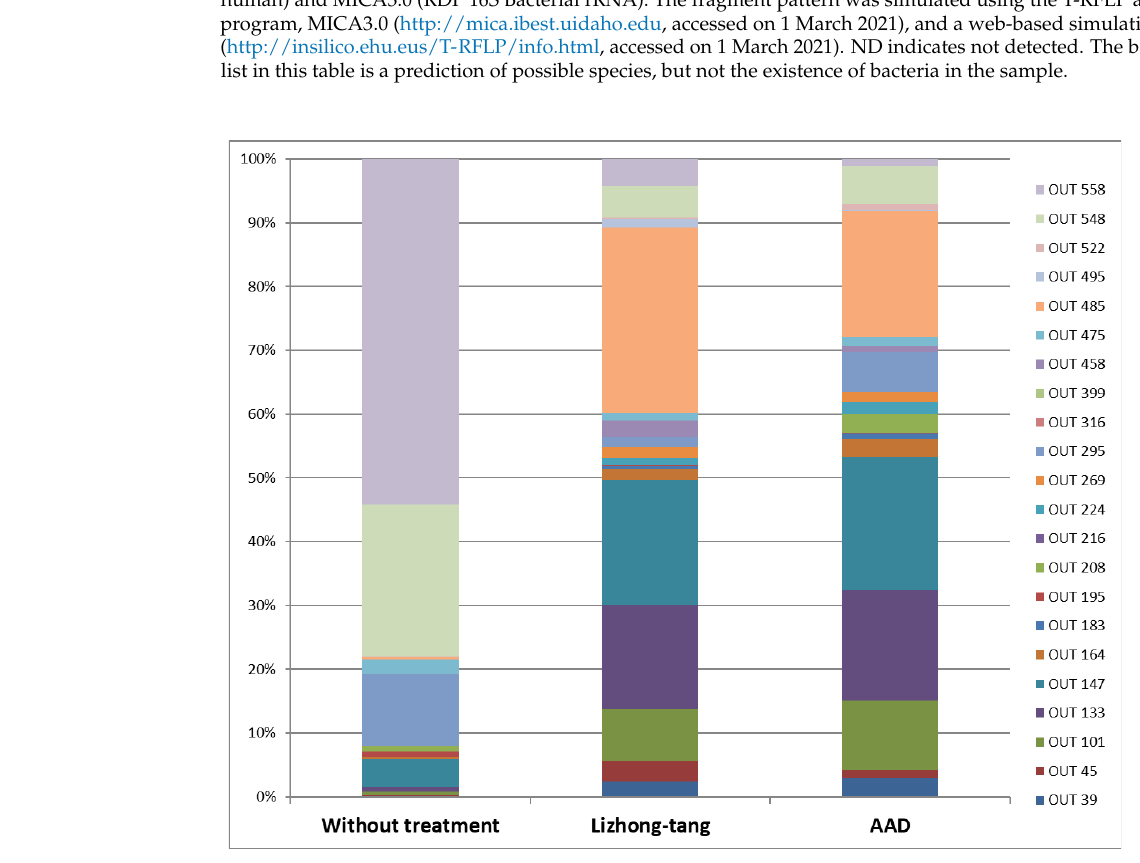
Figure 7. T-RFLP profiles of small intestinal contents, based on operational taxonomic units (OTUs). After the experiment, to assess the anti-diarrheal effect of Lizhong-tang on mice in an antibiotic-associated diarrhea (AAD) model induced by means of lincomycin oral administration, DNA was isolated from the feces-containing intestinal tissues of each mouse. The isolated DNA was analyzed using T-RFLP, with the help of CNGB (mouse and human) and MICA3.0 (RDP 16S bacterial rRNA) databases. Fragment pattern was simulated using the T-RFLP analysis program, MICA3.0